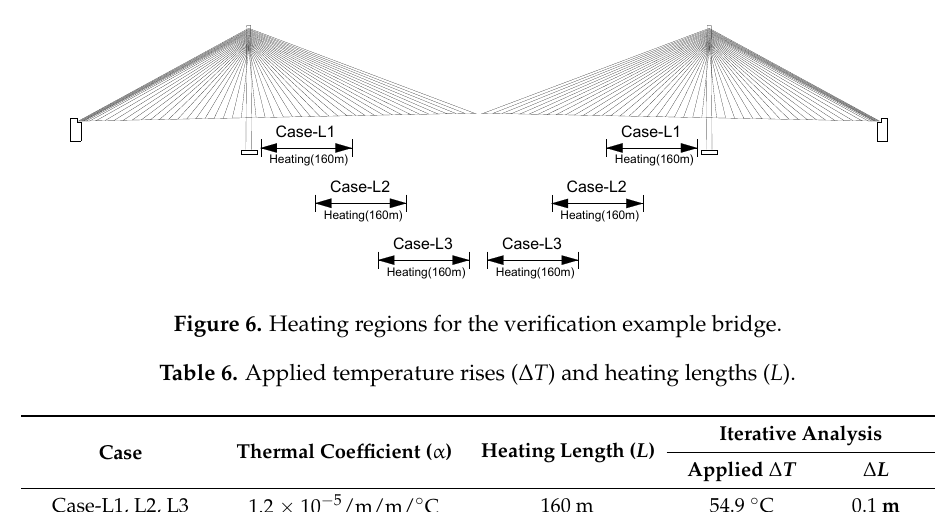
Table 6. Applied temperature rises ( Δ T ) and heating lengths ( L ).